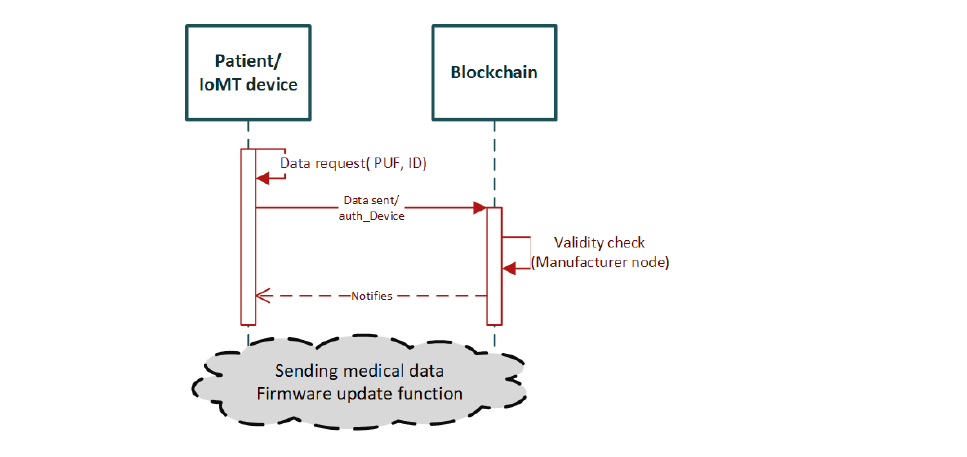
Figure 3. Sequence diagram summarizing the workflow of the proposed scheme in [36].